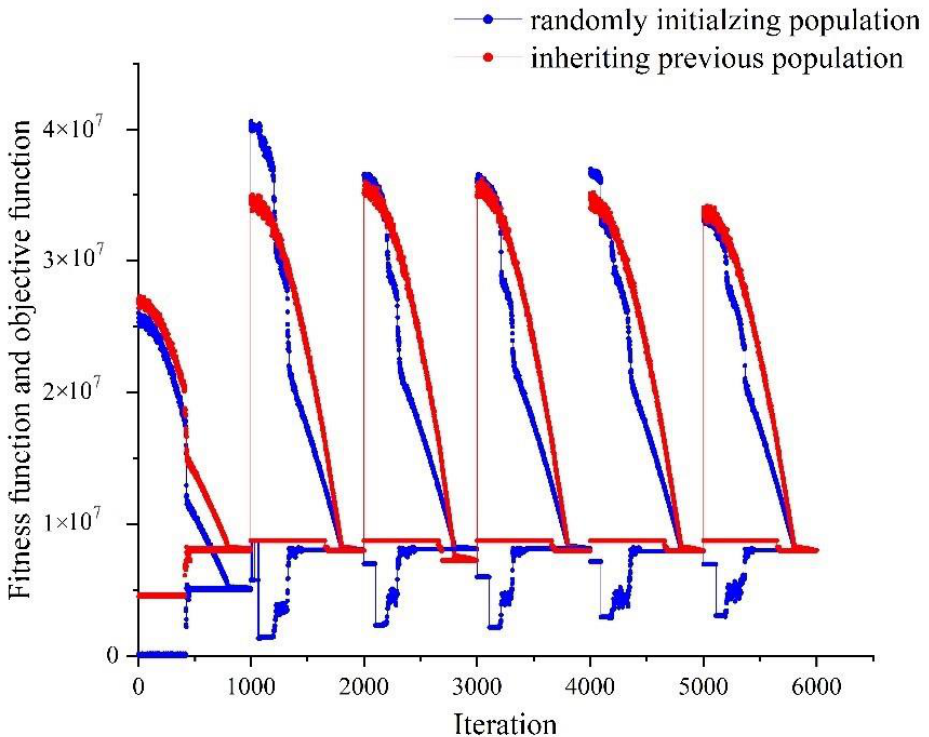
Figure 11. Convergence curve in the case of two different response strategies.